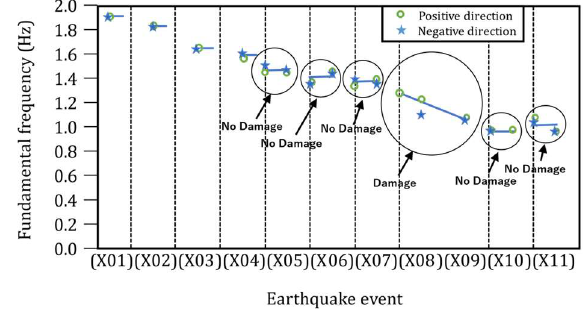
Figure 1. Change in the fundamental frequency of the structure of each earthquake event from 1998 (left) to 2012 (right) [12].